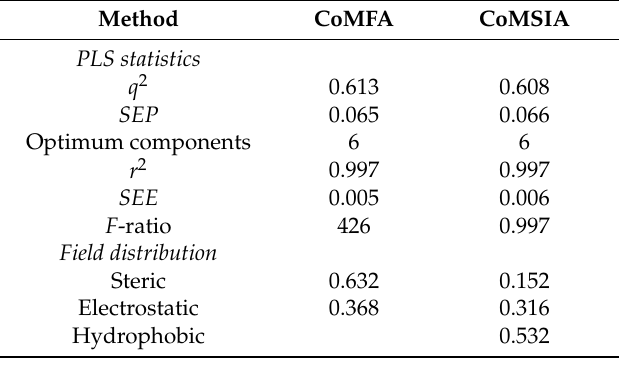
Table 4. Statistical parameters of CoMFA and CoMSIA model.